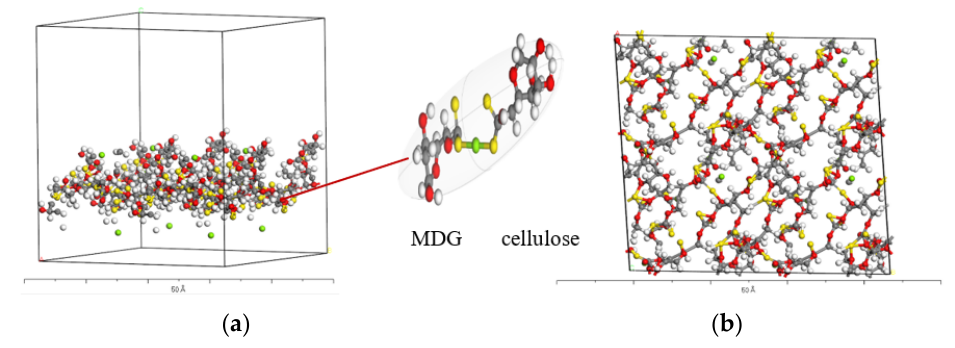
Figure 3. Cell structure of MDG fi ber ( − 1 1 0) surface optimization. ( a ) front view, ( b ) Top view.